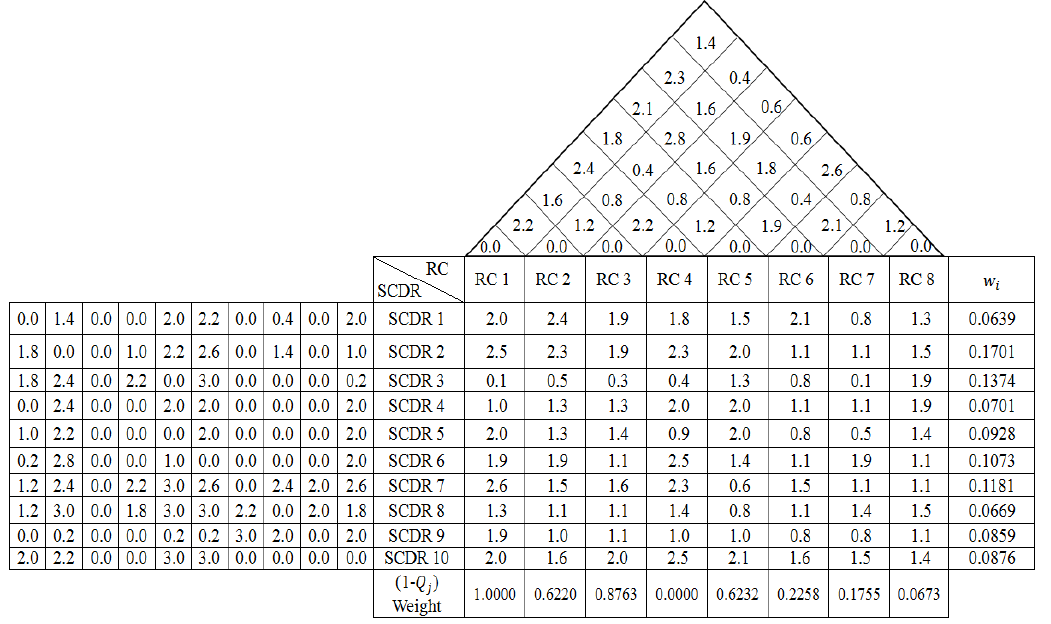
Figure 6. First house of quality (HoQ) between SSCDRs and